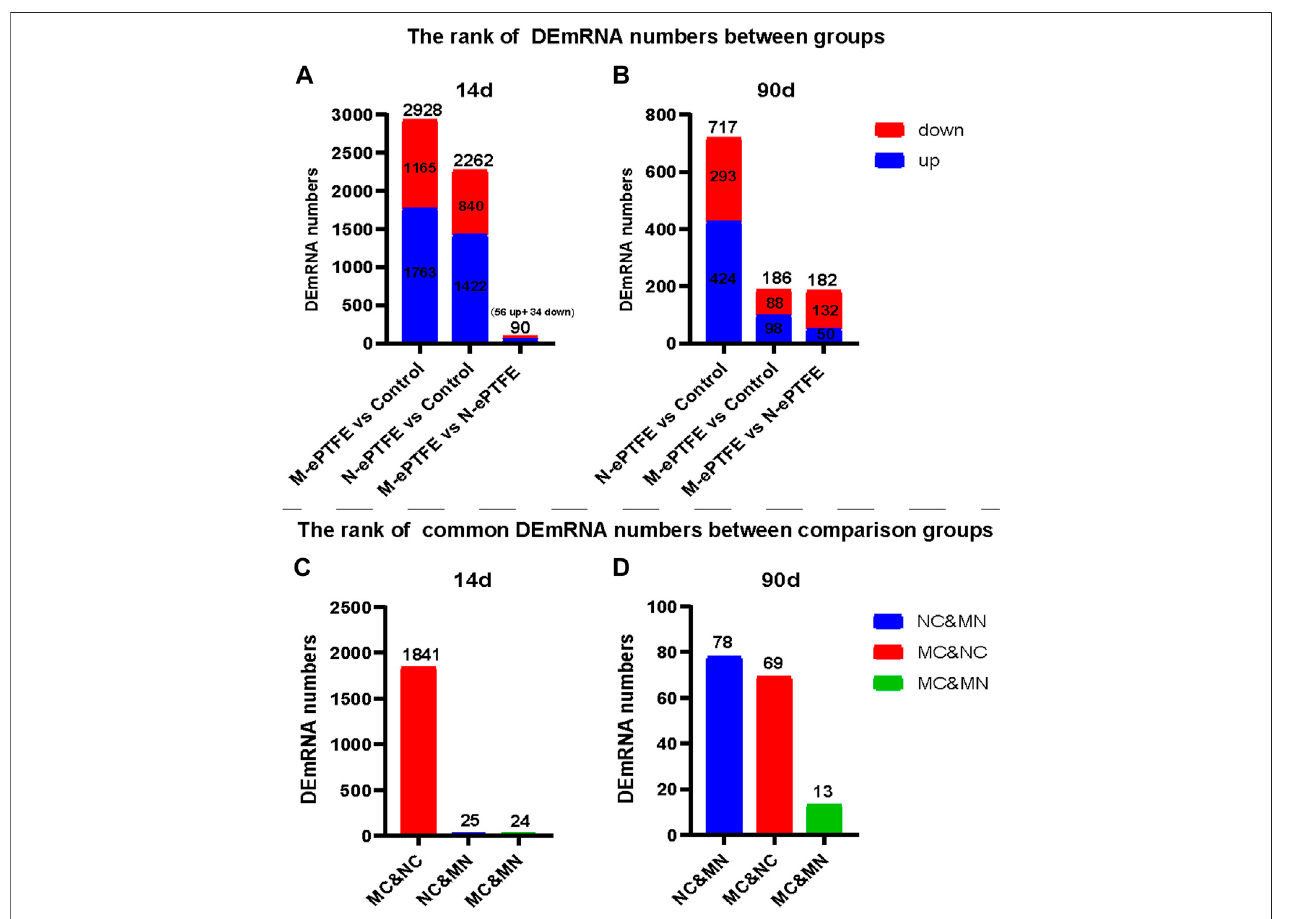
FIGURE 10 | Ranking of differentially expressed mRNA (DEmRNA) in the three groups. Total numbers of DEmRNAs (A,B) and numbers of common DEmRNAs (C,D) in different group comparisons: NC, unmodi fi ed expanded polytetra fl uoroethylene (N-ePTFE) vs Control comparison group; MC, modi fi ed (M-ePTFE) vs Control comparison group; MN: M-ePTFE vs N-ePTFE comparison